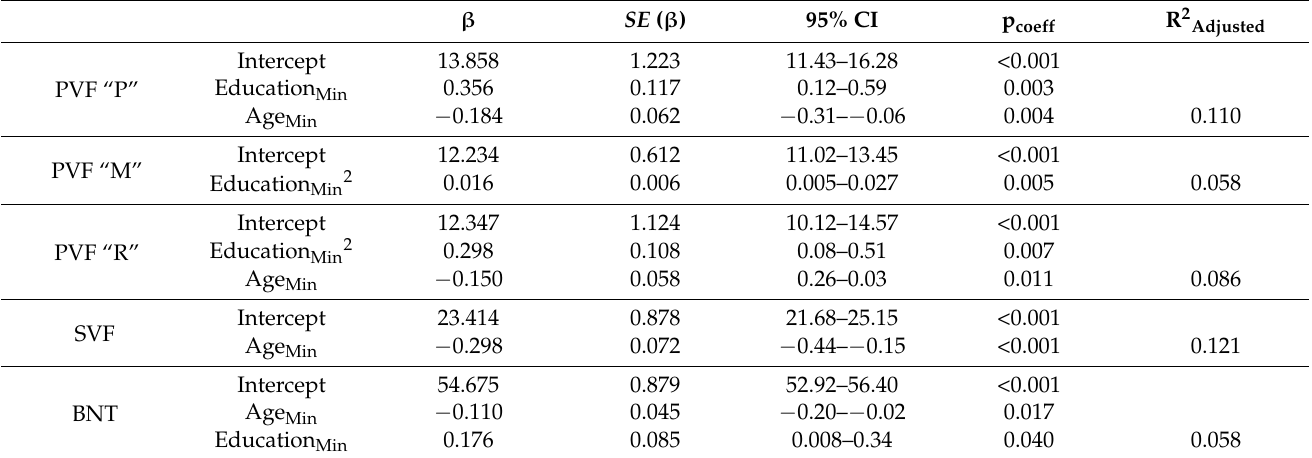
Table 4. Multiple linear regression